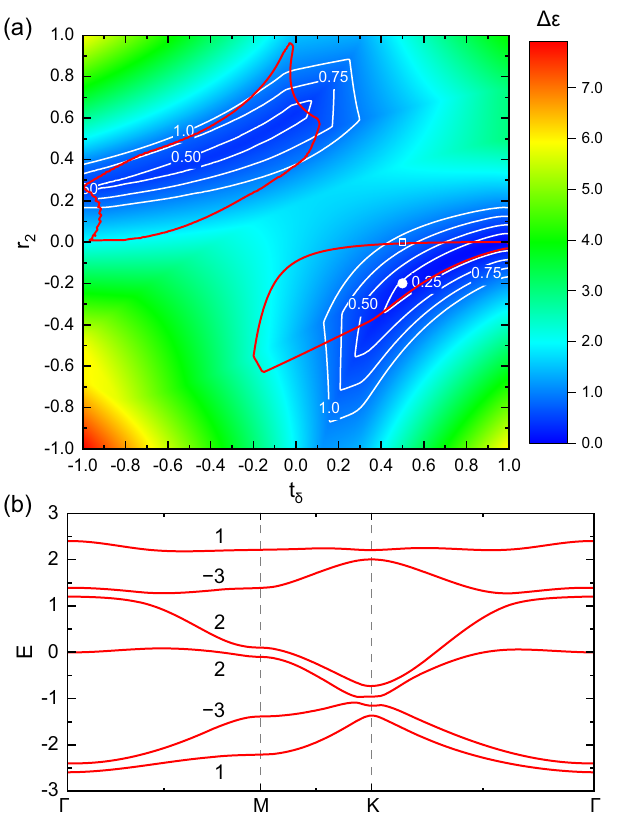
Fig. 3 Control of the band fl atness. a Color map of the fl atness Δ ε of the highest band as a function of t δ and the ratio between the nearest-neighbor and the second-neighbor hopping r 2 with λ = 0.2. Open square ( fi lled circle) locates t δ = 0.5 with r 2 = 0 ( − 0.2). Red closed loops show the areas where the band gap is positive Δ gap > 0. b Bulk band structure with t δ = 0.5, r = − 0.2, and λ = 0.2. Band-dependent Chern number is also shown. 2